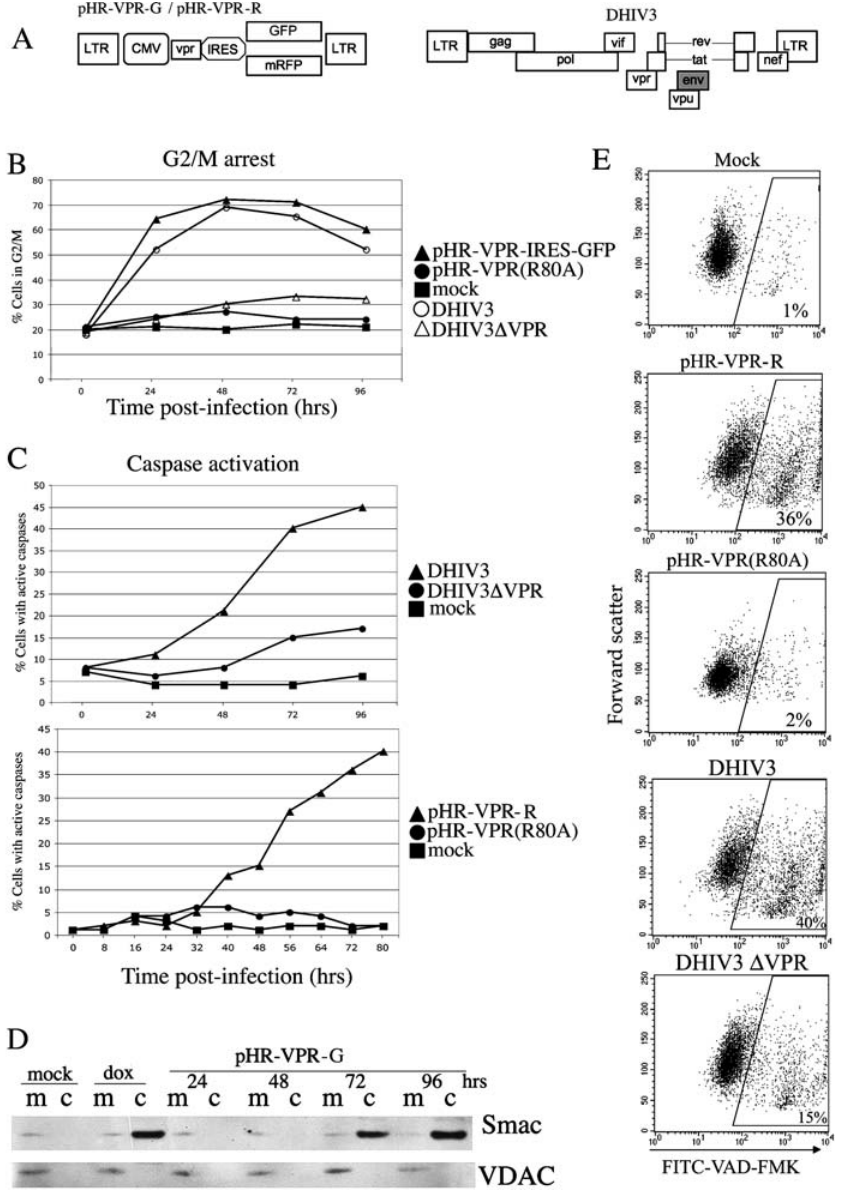
Figure 1. Vpr-Induced Caspase Activation and Smac Release from the Mitochondria Are Temporally Delayed in Relation to G 2 Arrest (A) pHR-VPR-G and pHR-VPR-R are bicistronic lentiviral vectors that encode HIV-1 NL4–3 vpr, an internal ribosome entry site, and either the gene for GFP or that for mRFP, respectively; pHR-VPR(R80A) was derived from pHR-VPR (both the mRFP and the GFP versions) by site-directed mutagenesis; DHIV3 is an envelope-truncated (see gray box) version of HIV-1 NL4–3 ; DHIV3- D VPR was derived from DHIV-3 by introducing a frameshift mutation in vpr . (B) SupT1 T lymphocytes were transduced by spin-infection in the presence of 10 l g/ml Polybrene with indicated vectors. Mock-infected cells were subjected to spin-infection in the presence of 10 l g/ml Polybrene without virus. Cells were collected at specified time points post-transduction, stained with propidium iodide, and analyzed for DNA content by flow cytometry to determine cell cycle profiles. The percentage of cells transduced with pHR vectors and DHIV3 viruses ranged between 70% to 80% and between 65% to 70%, respectively, as determined by mRFP or GFP expression (with pHR vectors) or intracellular p24 staining (with DHIV3 vectors). (C) Caspase activation was measured as an indication of apoptosis. SupT1 cells were infected with indicated vectors, harvested, and incubated with FITC-VAD-FMK. The percentage of caspase-active cells at each time point was measured by flow cytometry. (D) Infected SupT1 cells were lysed, and lysates were fractionated into mitochondrial (m) and cytoplasmic (c) fractions and then assayed by Western blot. Western blots were probed with antibodies specific to Smac to measure release from mitochondria and with anti-VDAC antibodies to measure mitochondrial contamination in the cytoplasmic fractions. As a positive control for apoptosis, SupT1 cells were treated with 0.8 l g/ml doxorubicin (dox) for 48 h. (E) Examples of flow cytometric analysis of caspase activation, corresponding to the 72-h time points from (C).